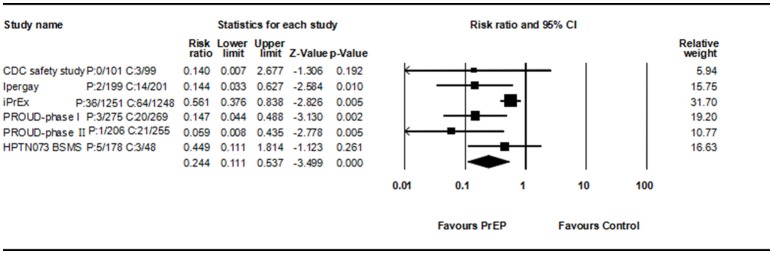
Forest plot for overall analysis of PrEP and HIV incidence (RR).